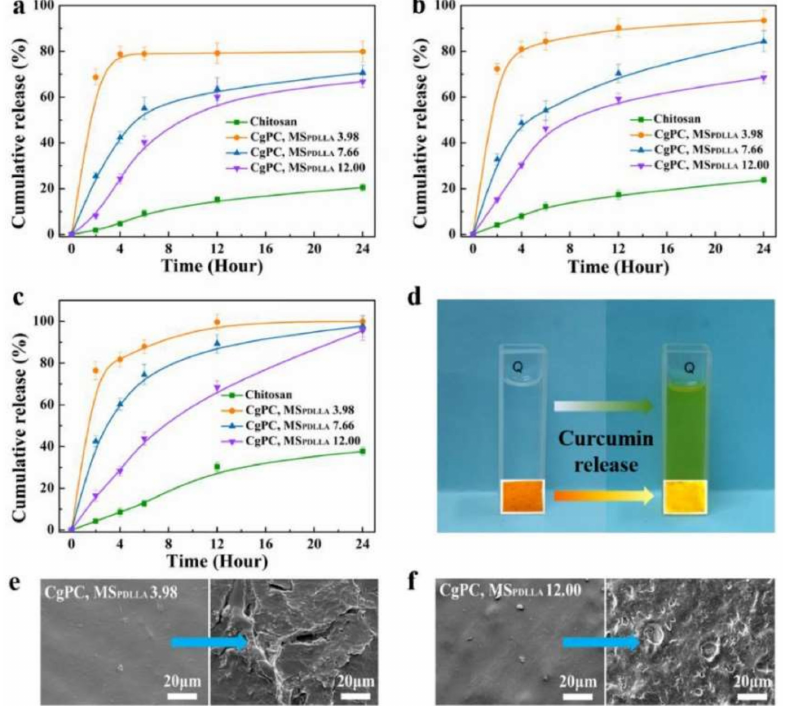
Figure 6. Drug release from chitosan and CgPC films in PBS ( a ), lysozyme ( b ) and porcine pancreas lipase ( c ). Color changes of the medium and film after curcumin release ( d ). SEM images of curcumin- loaded CgPC films (MS-PDLLA 3.98) before and after drug release in porcine pancreas lipase ( e ). SEM images of curcumin-loaded CgPC films (MS-PDLLA 12.00) before and after drug release in porcine pancreas lipase ( f ). Obtained from reference [131]. Copyright @ 2021 Elsevier, License Number: